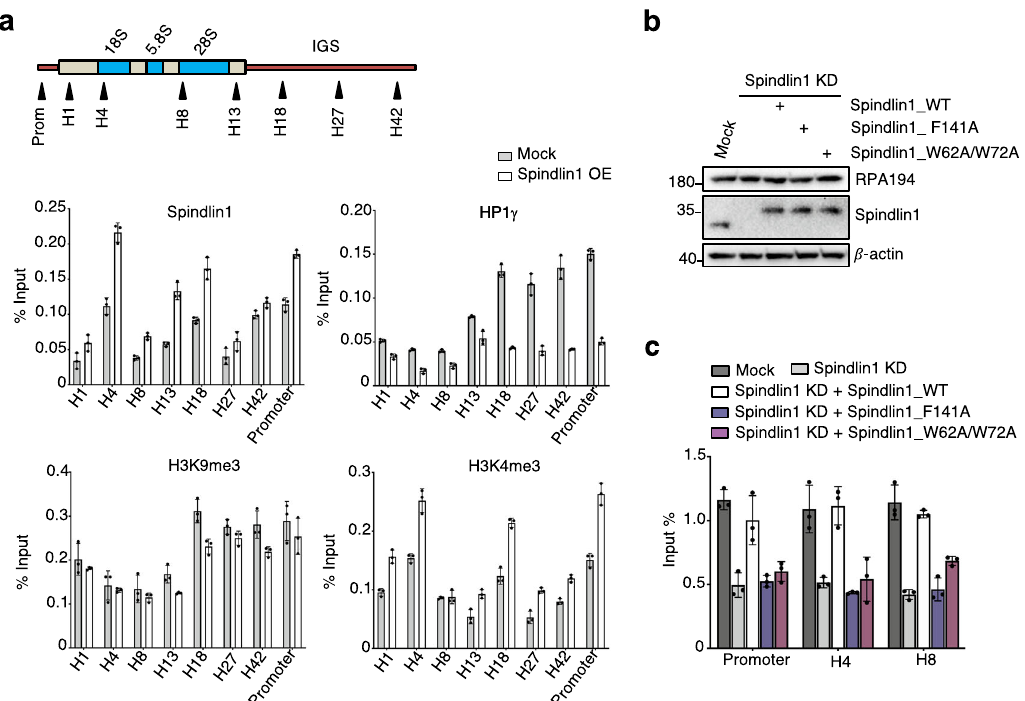
Fig. 4 Spindlin1/C11orf84 complex displaces HP1 γ from the rDNA foci enriched with H3K4me3K9me3 bivalent mark and facilitates the recruitment of RNA Pol I. a The top panel is a schematic diagram of a rDNA repeat. Arrows indicate the positions of eight primer pairs designed for qPCR analysis of immunoprecipitated DNA. The lower four panels are ChIP-qPCR measurement of the relative occupancy of Spindlin1, HP1 γ , H3K9me3, and H3K4me3 on different regions of rDNA in HEK293T cells expressing Myc-tagged Spindlin1 or an empty vector (Mock). The precipitated DNA was analyzed by qPCR using primers that amplify the regions of H1: 5 ′ ETS (external transcribed spacer); H4: 18S rRNA coding; H8: 28S rRNA coding; H13: 3 ′ ETS; H18, H27, H42: IGS (intergenic spacer); Prom: promoter. The y- axis depicts the ChIP/input ratio. Data are presented as mean ± SD ( n = 3 independent experiments). b Immunoblotting shows the protein level of RPA194 remains relatively stable in Spindlin1-depleted U2OS cells ectopically expressing Spindlin1 wild type or mutants. c ChIP-qPCR analysis of the recruitment of RPA194 (RNA Pol I subunit) to rRNA gene promoter and coding regions (H4 and H8) in Spindlin1 KD cells, Spindlin1 KD cells expressing Myc-tagged Spindlin1 wild type or indicated mutants compared with mock cells. Results are presented as mean ± SD ( n = 3 independent experiments). Source data are provided as a Source Data fi